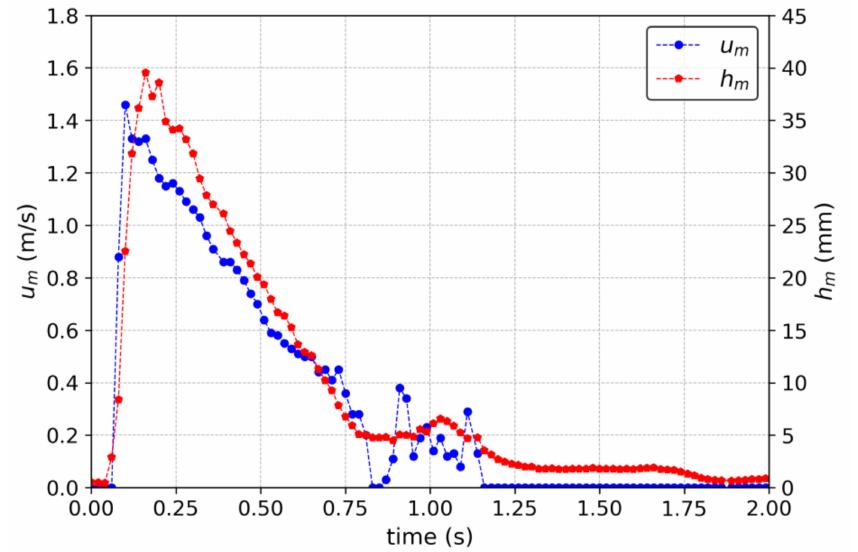
Figure 6. OFV ( u m ) and OLT ( h m ) at the rear edge breakwater crest. The wave condition was T = 2.75 s and H = 16